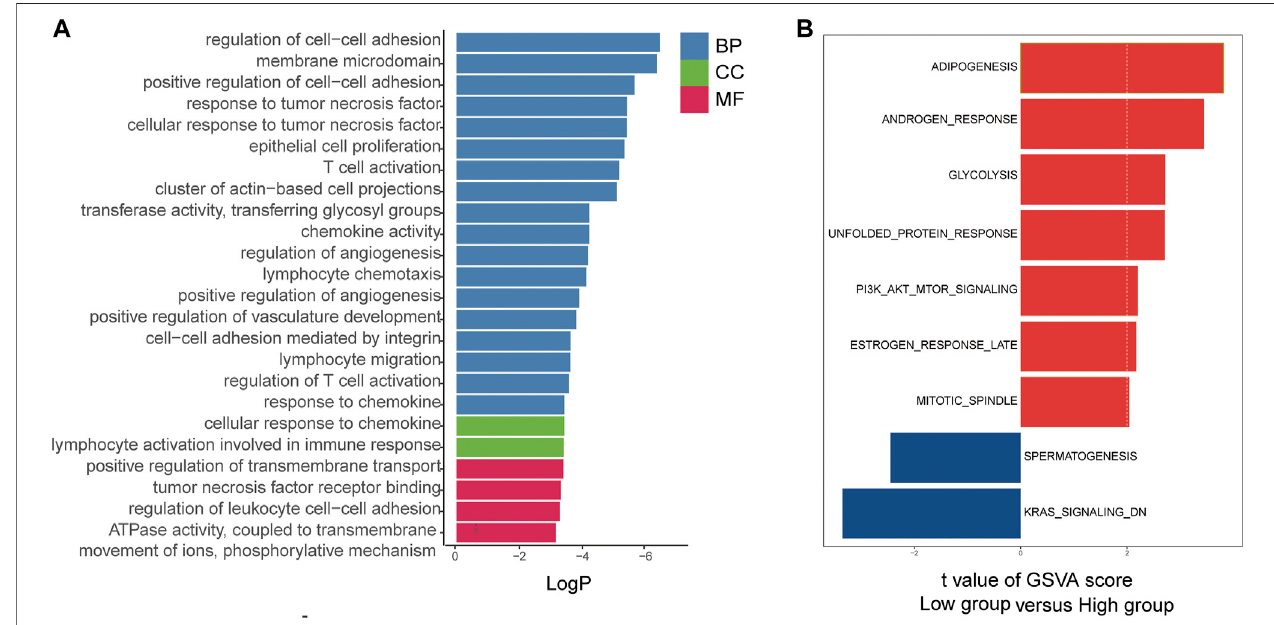
FIGURE 9 | Functional annotation of the two risk groups in the TCGA cohort. (A) The GO enriched gene pathways/functions in distinct metastasis risk signature groups from TCGA CRC patients. (B) The hallmark enriched gene pathways/functions in distinct metastasis risk signature groups from TCGA CRC patients.